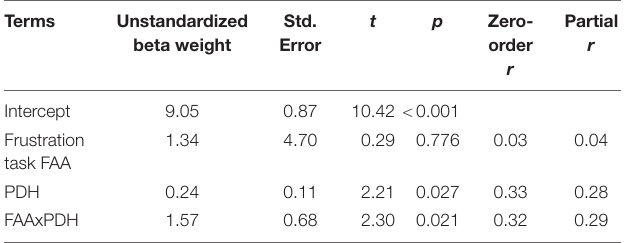
TABLE 2 | Parenting daily hassles and frustration task EEG as predictors of externalizing